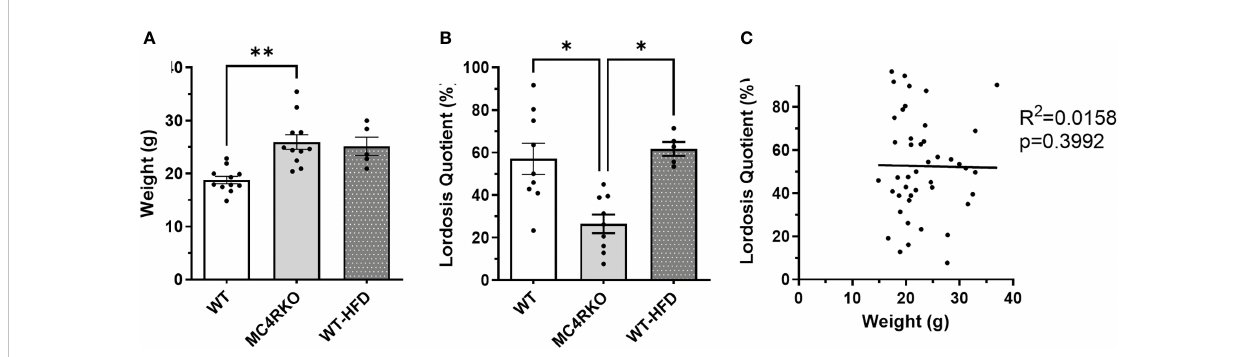
FIGURE 1 Mice fed HFD had normal sexual function at two months of age. (A) Weight of WT (n=11), MC4RKO (n=11), and WT mice on HFD (WT-HFD) (n=5). Brown-Forsythe and Welch ANOVA with Dunnett ’ s T3 multiple comparisons test. WT vs MC4RKO (p=0.003) and WT-HFD (p=0.101). (B) Lordosis quotient between WT (n=9), WT-HFD (n=5), and MC4RKO mice (n=9). One-way ANOVA with Sidak ’ s multiple comparison test was used: WT vs MC4RKO (p=0.018); MC4RKO vs WT-HFD (p=0.023). (C) All mouse groups were combined (n=44) to run correlation analysis on weight vs lordosis quotient. *p<0.05;